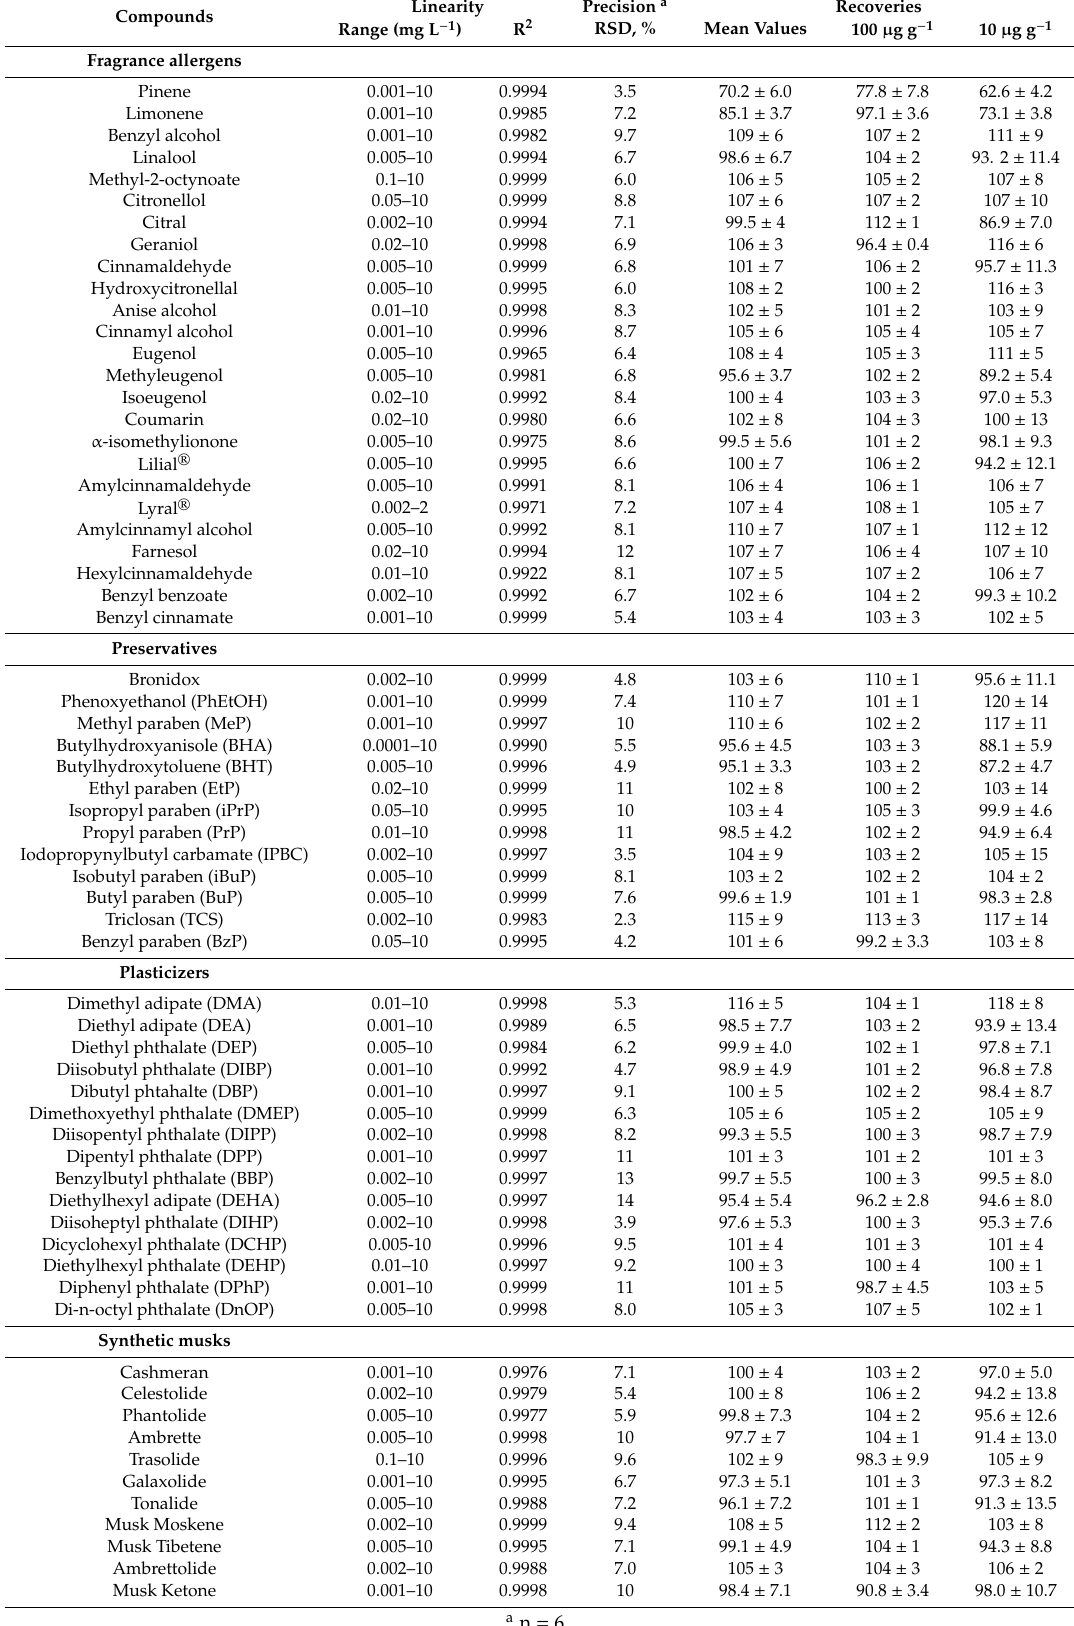
Table 5. µ -MSPD-GC–MS / MS performance for the fragrance allergens, preservatives, plasticizers and synthetic musks. Linearity, precision, and recovery studies.